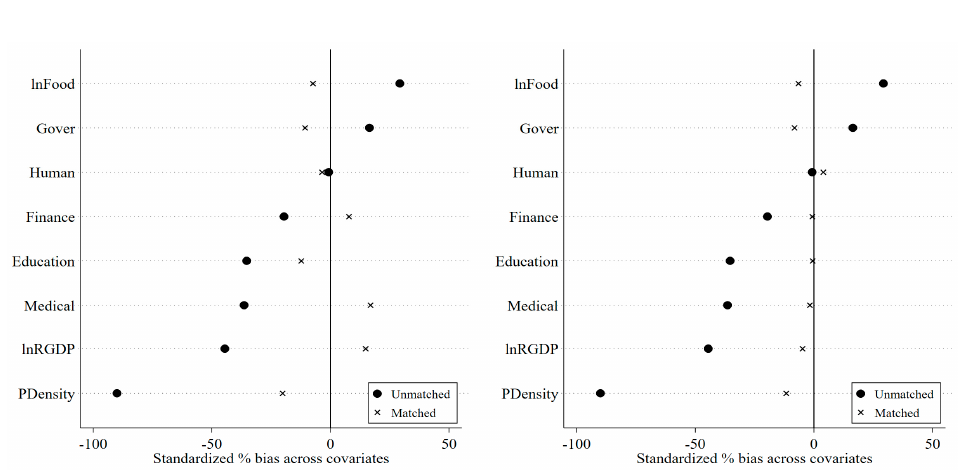
Figure 1. Balance test of covariates before and after propensity score matching. Note: The figure was drawn using Stata 16.0.